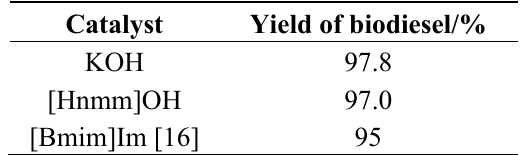
Table 2. Comparison of catalysis with different